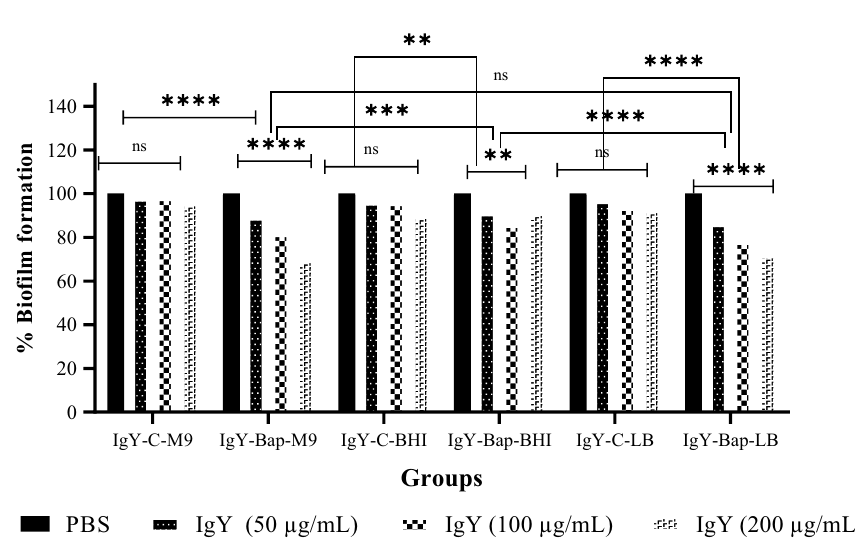
Figure 4. Effect of therapeutic IgY on biofilm disruption in M9, BHI, and LB media. Formation of biofilm in different media against each IgY-Bap group was compared with that of PBS as well as IgY-C groups. The IgY-Bap groups were also compared separately as well as with each other (ns; not significant, ** p < 0.01; *** p < 0.001; **** p <